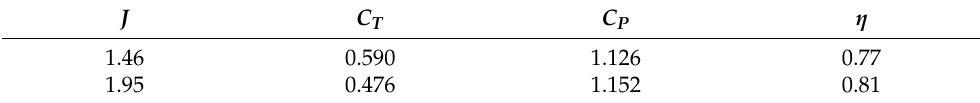
Table 1. Desired propeller